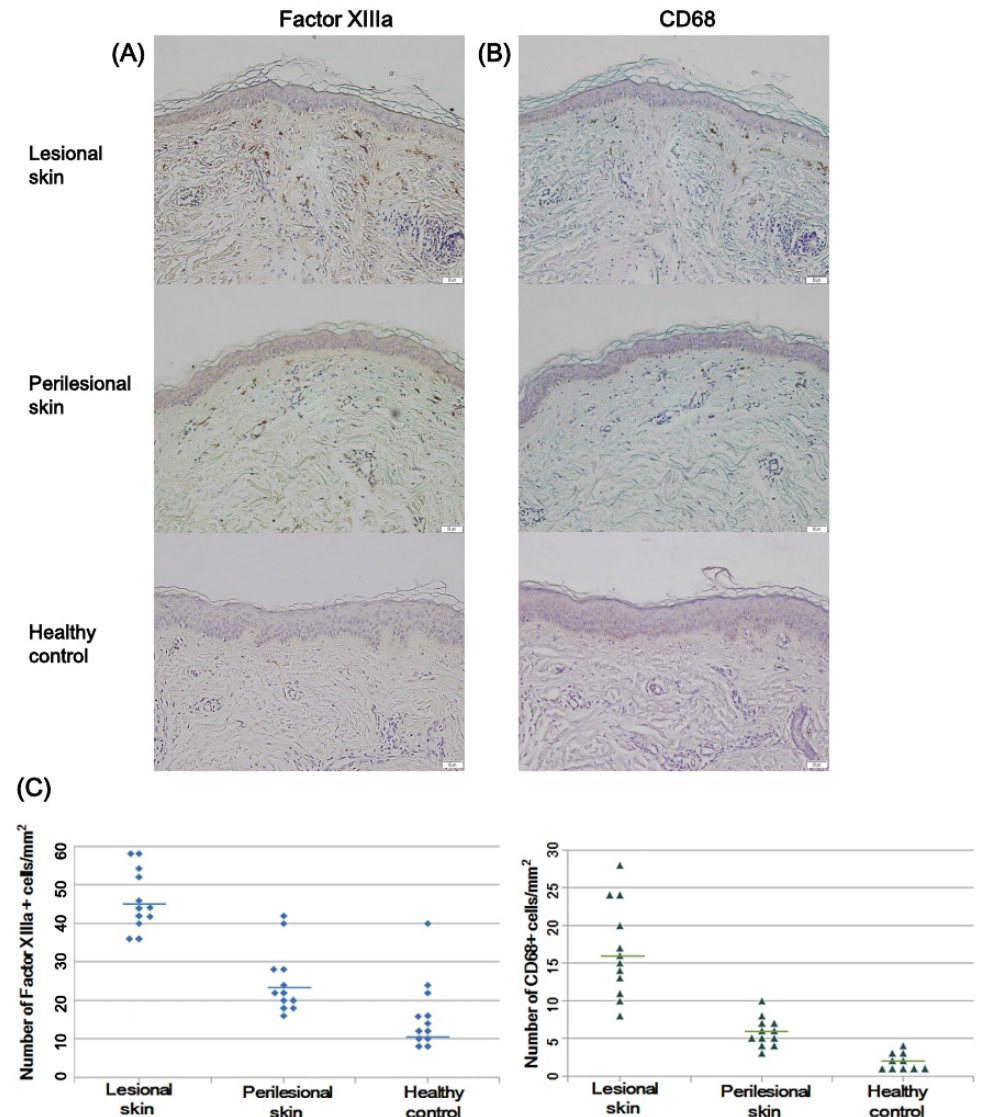
Figure 3. Immunostaining with factor XIIIa and CD68 for dermal infiltrating cells. ( A ) The number of factor XIIIa-positive dermal pigment-laden cells was increased in the lesional skin of Riehl’s melanosis compared to perilesional skin and healthy controls (original magnification, 200 × ). Scale bar, 50 µ m. ( B ) The number of CD68-positive dermal pigment-laden cells was increased in the lesional skin of Riehl’s melanosis compared to perilesional skin and healthy controls (original magnification, 200 × ). Scale bar, 50 µ m. ( C ) The scatter plot reveals the number of factor XIIIa and CD68-positive cells per unit area in the lesional skin and perilesional skin of Riehl’s melanosis and healthy controls. The bar indicates the mean value of respective